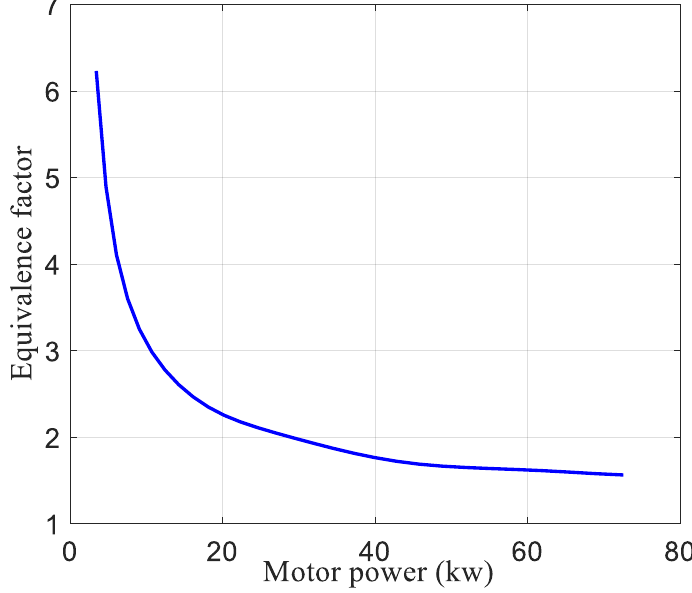
Figure 6. The fitting curve between motor power and equivalence factor.